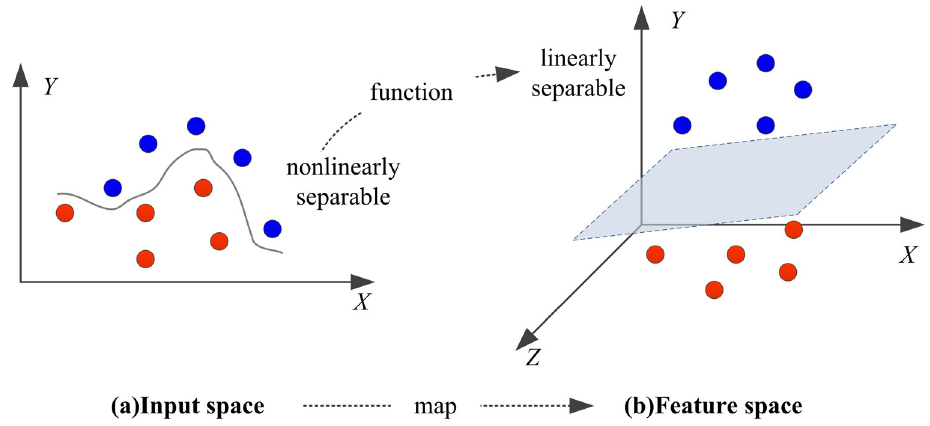
Figure 3. 2D input space mapping into 3D feature space to separate data